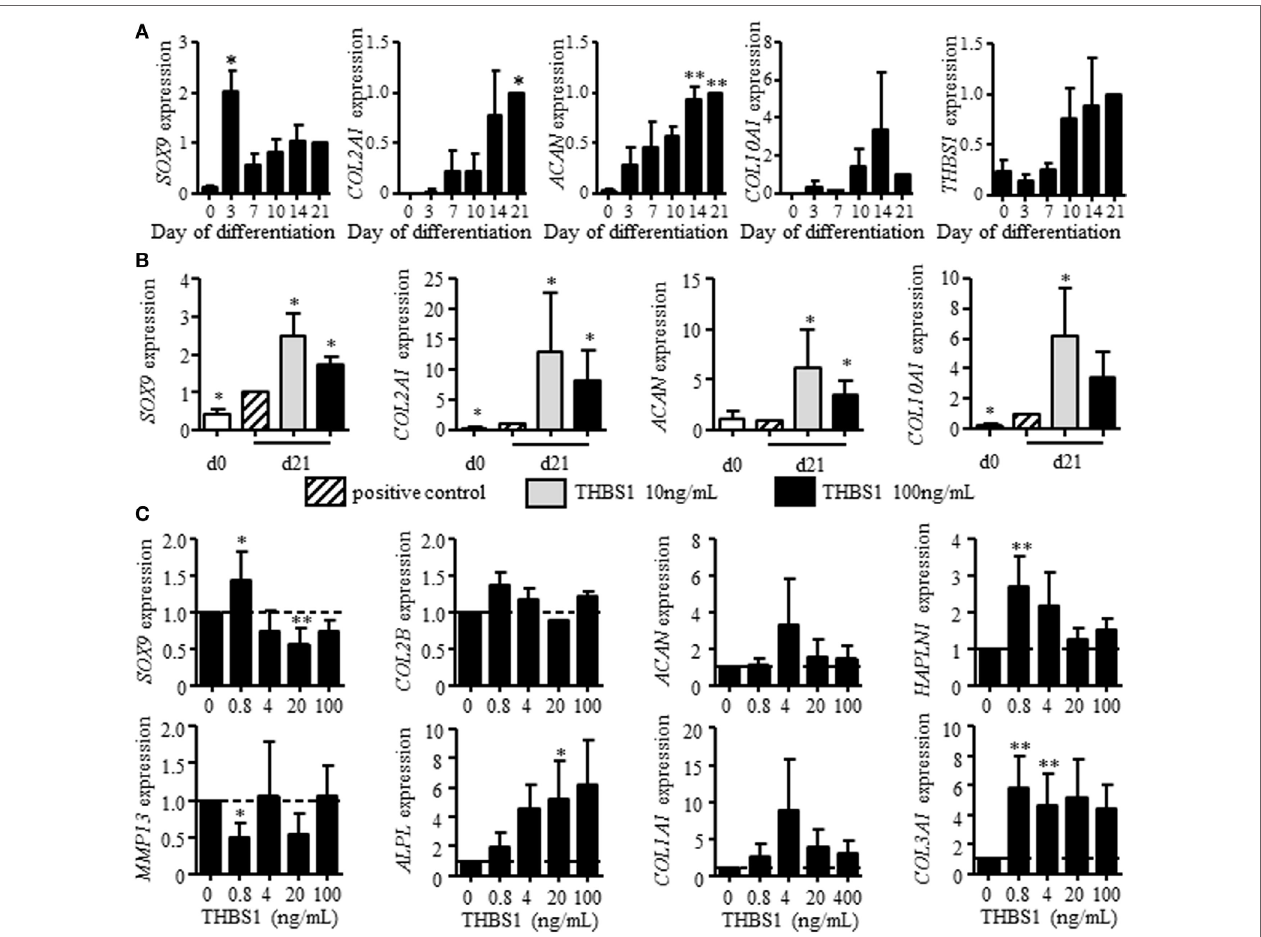
FigUre 2 | Effect of recombinant thrombospondin-1 (THBS1) on chondrogenesis and osteoarthritic chondrocyte phenotype. (a) Relative expression of markers specific for chondrocytes [ SOX9 , collagen type II variant B ( COL2A1 ), aggrecan ( ACAN ), collagen type X ( COL10A1 )] or THBS1 at different time points during differentiation of mesenchymal stem cells (MSCs) into chondrocytes or (b) after treatment with 10 or 100 ng/mL of THBS1 from days 14 to 21 of differentiation. Results are normalized to gene expression level in positive control (TGF β 3-induced differentiation of MSC) at day 21 and represented as mean ± SEM of four biological replicates. (c) Markers of mature chondrocytes ( SOX9, COL2A1 variant B, ACAN , and HAPLN1 ), hypertrophic chondrocytes ( MMP13, ALPL ), and fibrocartilage ( COL1A1, COL3A1 ) were quantified in osteoarthritic chondrocytes treated with different concentrations of recombinant THBS1 (rTHBS1) ( n = 5 biological replicates). Results are expressed as fold change of gene expression compared to untreated chondrocytes and represented as mean ± SEM. Statistics used Mann–Whitney test: * p ≤ 0.05, ** p ≤